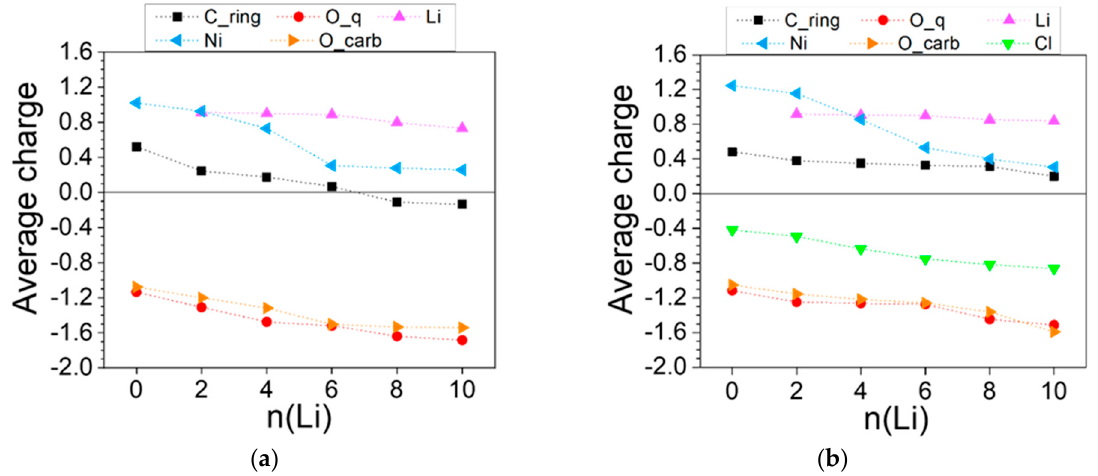
Figure 9. Averaged AIM charges in the lithiated ( a ) [Ni(II)L2] n and ( b ) [Ni(IV)L2] n . Numerical values can be found in Tables S8 and S9.